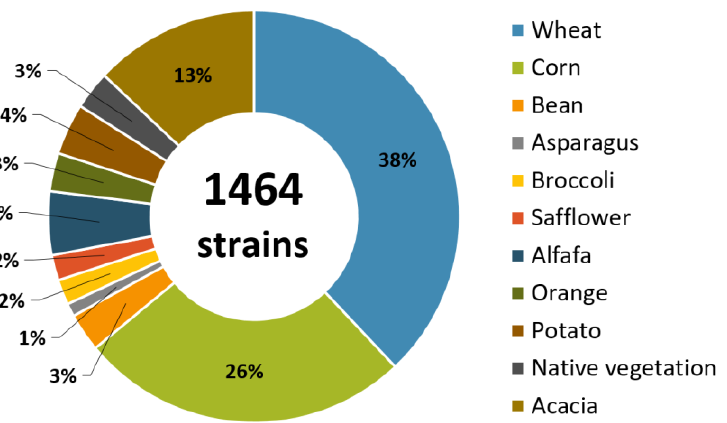
Figure 2. Percentage of microbial strains preserved in COLMENA isolated from soils associated with various economically important crops located in the Yaqui Valley, Sonora and the Fuerte Valley, Sinaloa, Mexico.